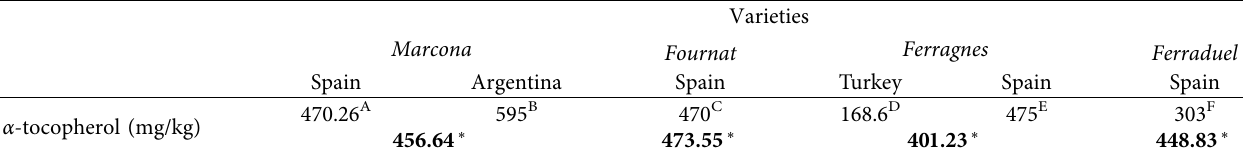
Table 3: α -tocopherol content in almond oil of four European varieties planted in eastern Morocco compared to that in Spain, Turkey, and Argentina.